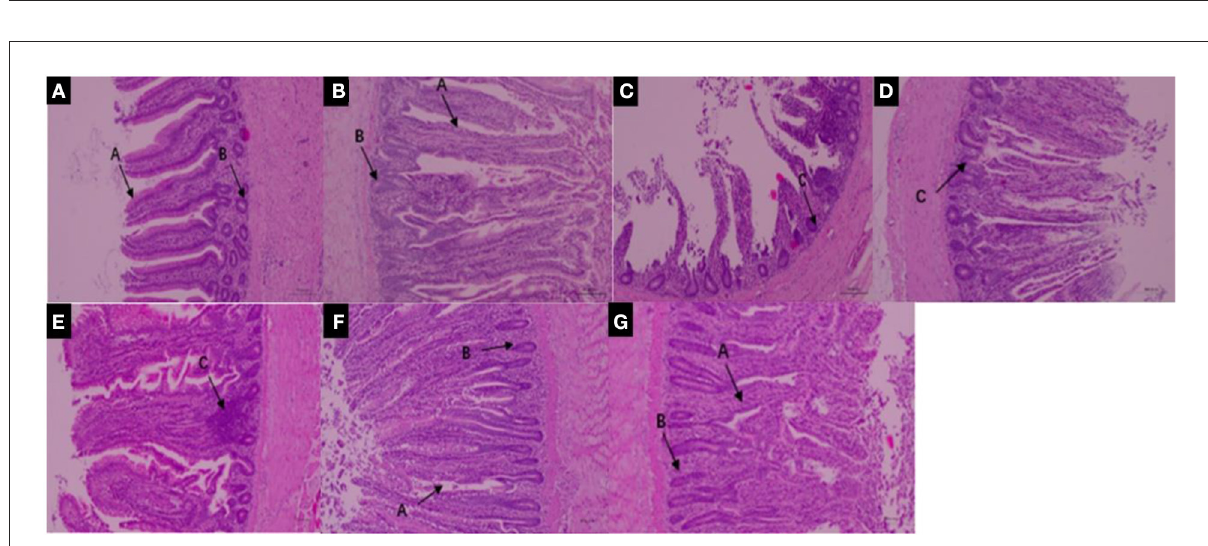
FIGURE5 (A–D) Ileum structure under 100 × magnification during treatment with deltamethrin for 0 (A) , the 1st (B) , 7th (C) , and 14th day (D) . (E–G) Ileum structure under 100 × magnification at the 1st (E) , 7th (F) , and 14th day (G) during deltamethrin treatment withdrawal. A, intestinal villi; B, intestinal glands (intestinal crypts); C, local mucosal lymphocyte infiltration; D, absence of intestinal villi